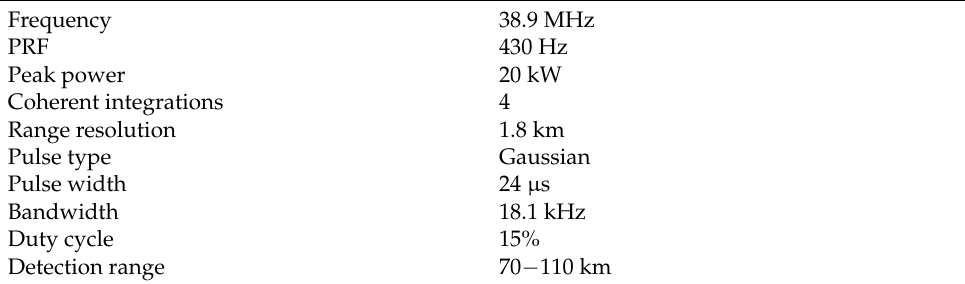
Table 1. Main parameters of the Mengcheng meteor radar. Frequency 38.9 MHz PRF Peak power Coherent